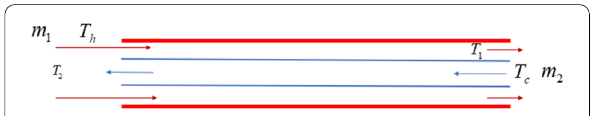
Figure 3 Flow direction of countercurrent heat